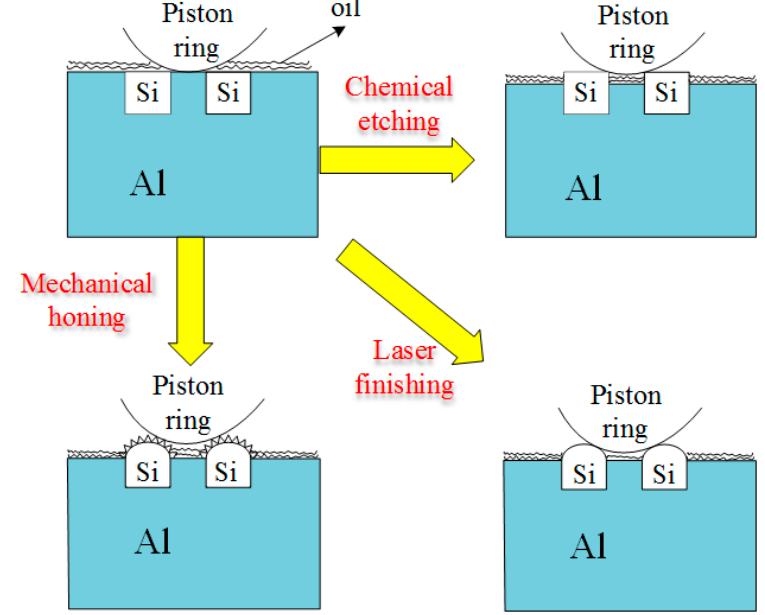
Figure 18. Schematic diagram of the wear mechanism.